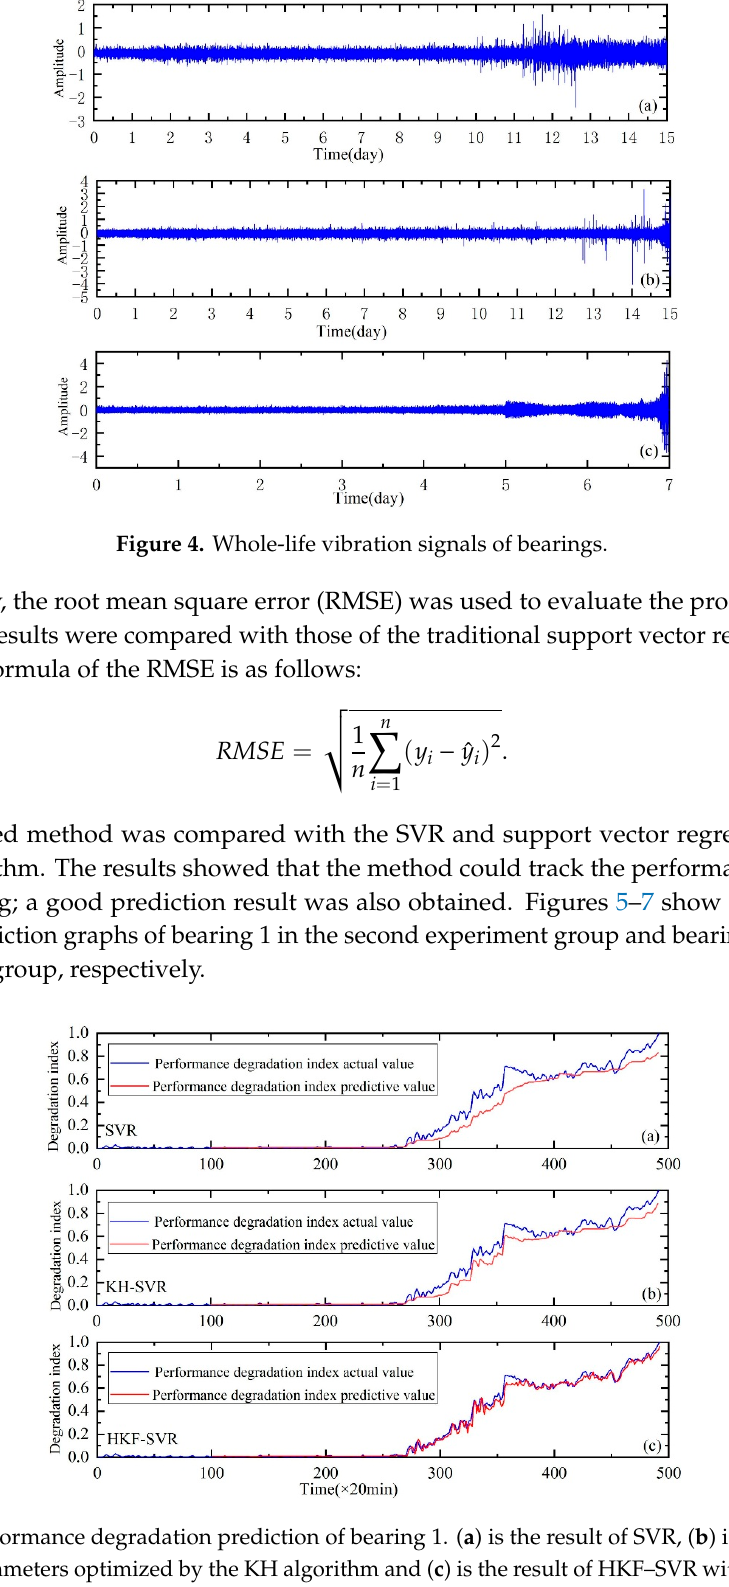
Figure 6. Performance degradation prediction of bearing 3. ( a ) is the result of SVR, ( b ) is the result of SVR with parameters optimized by the KH algorithm and ( c ) is the result of HKF–SVR with parameters optimized by the KH algorithm.